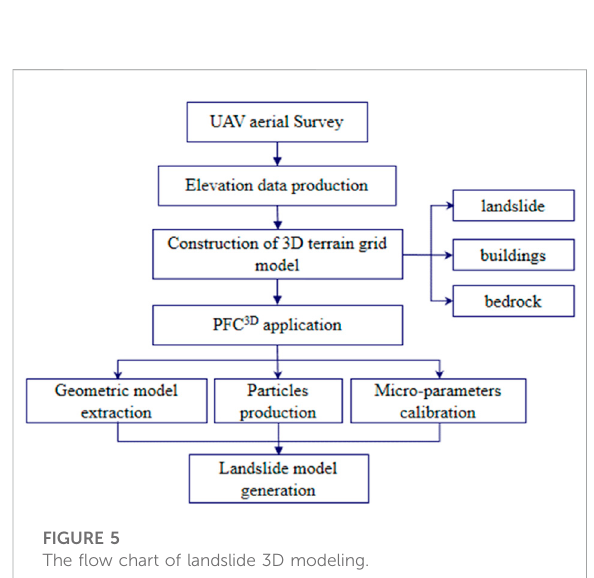
FIGURE 5 The fl ow chart of landslide 3D